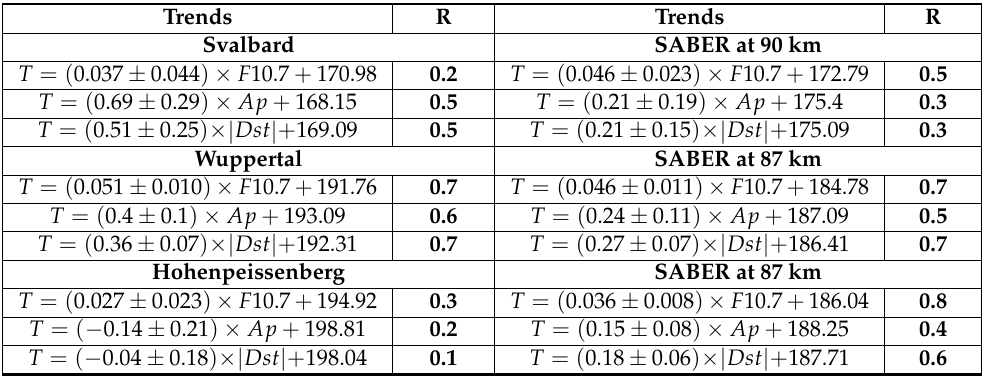
Table 3. Trends with correlation coefficient R after a cooling trend of 0.05 K/y was removed from the